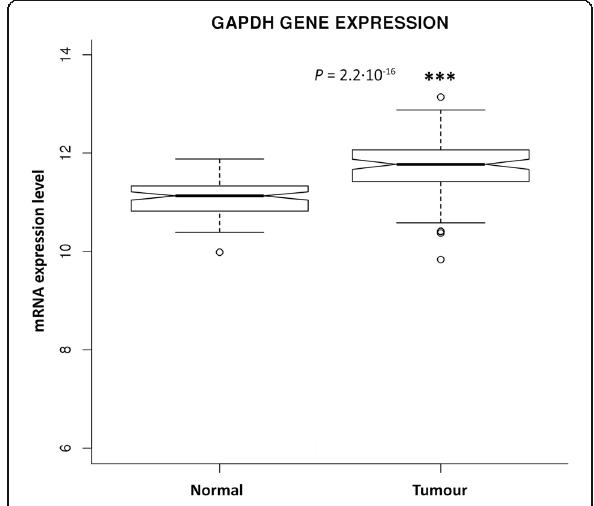
Fig. 5 GAPDH gene expression. Gene expression levels of GAPDH in normal and tumour colorectal tissue samples ( P = 2.2 · 10 -16